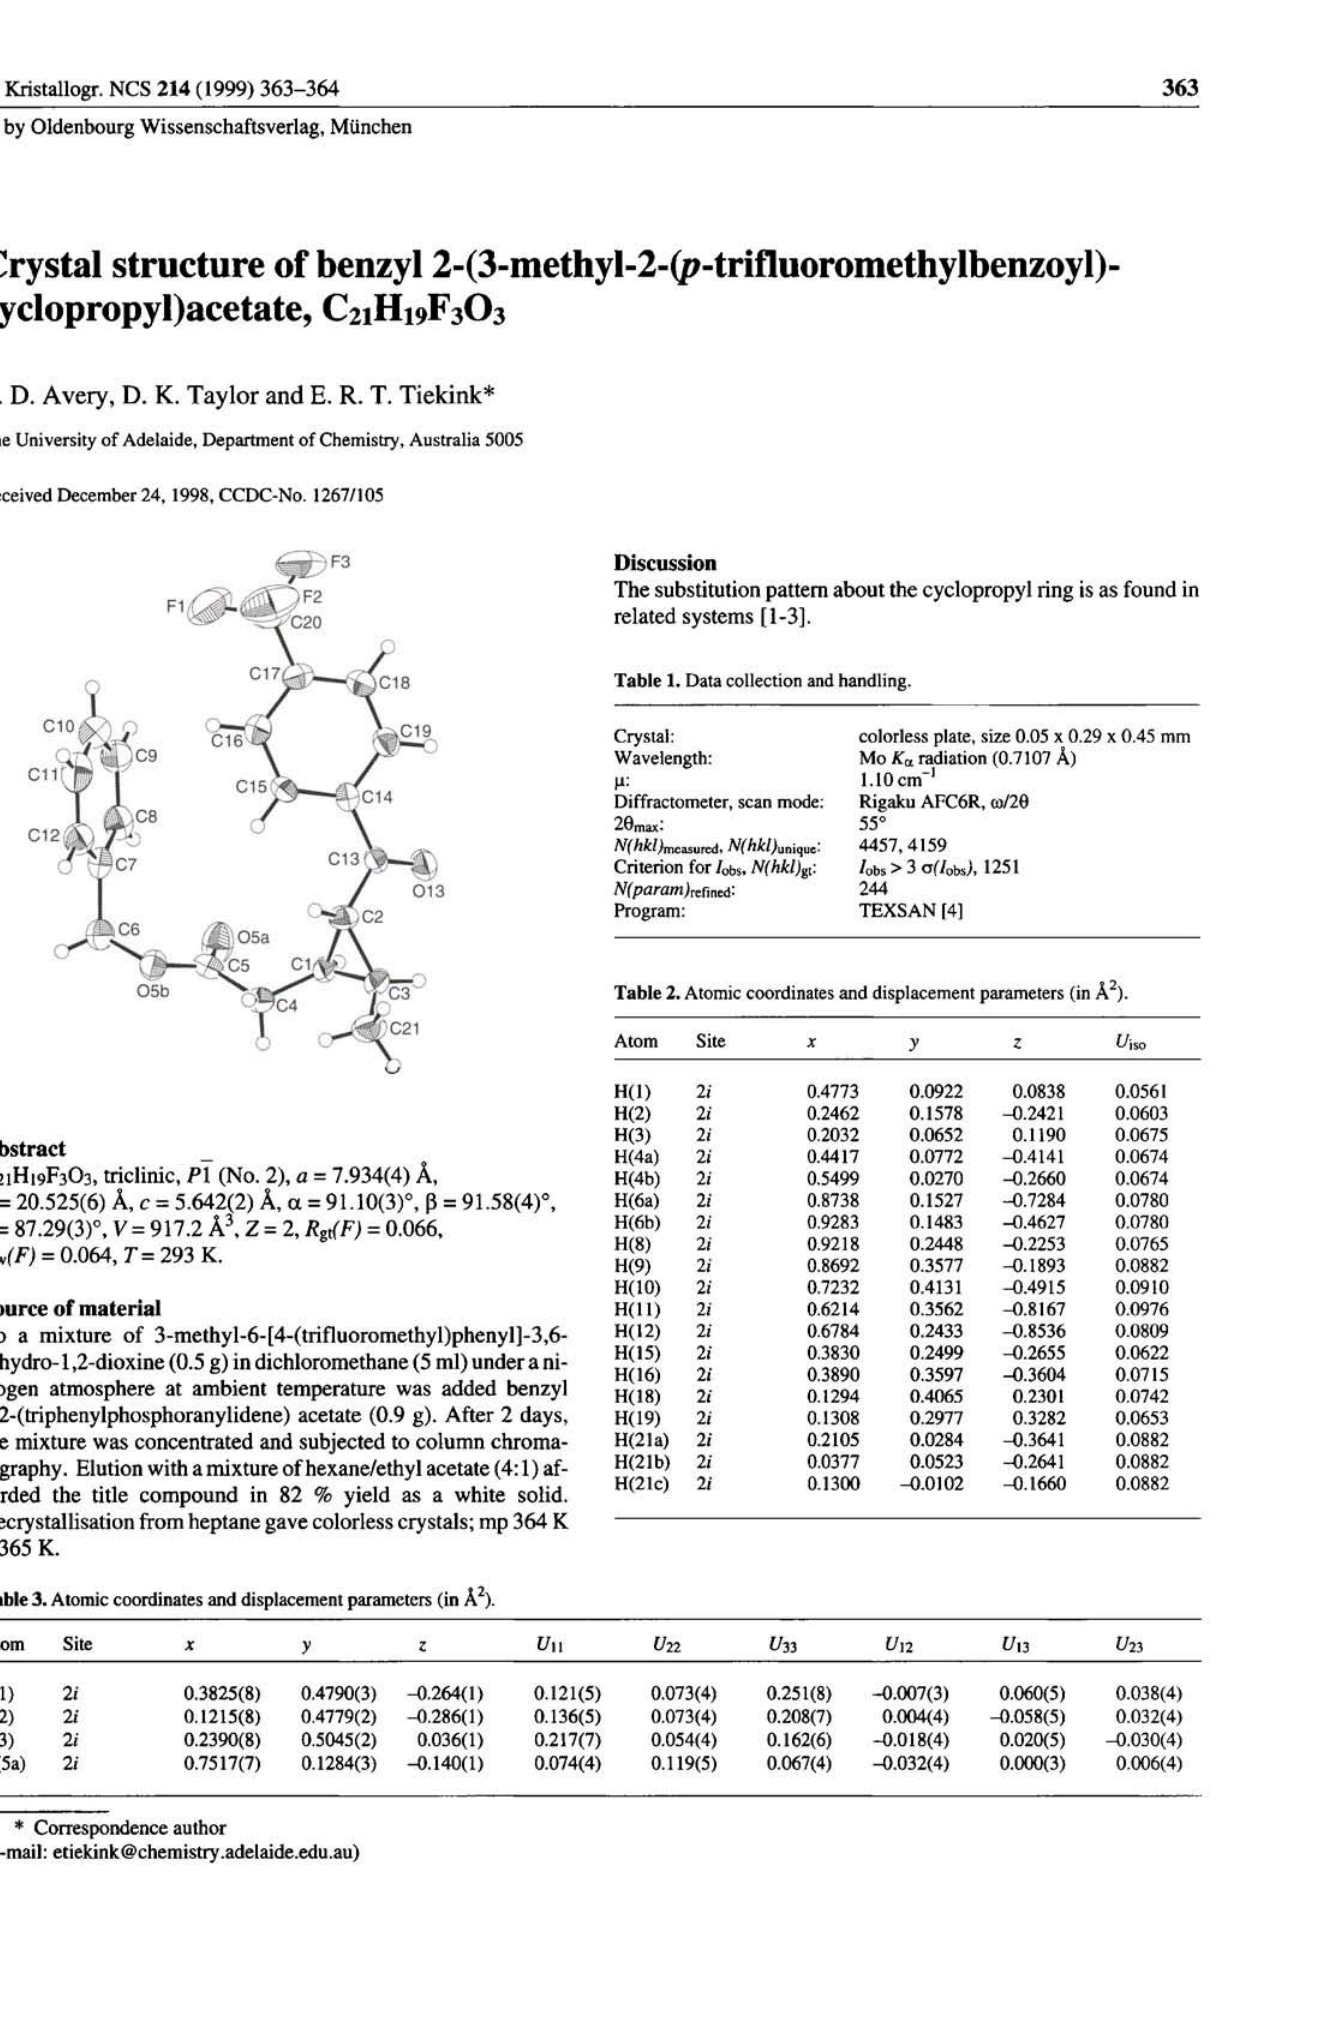
Table 3. Atomic coordinates and displacement parameters (in Â 2 ).